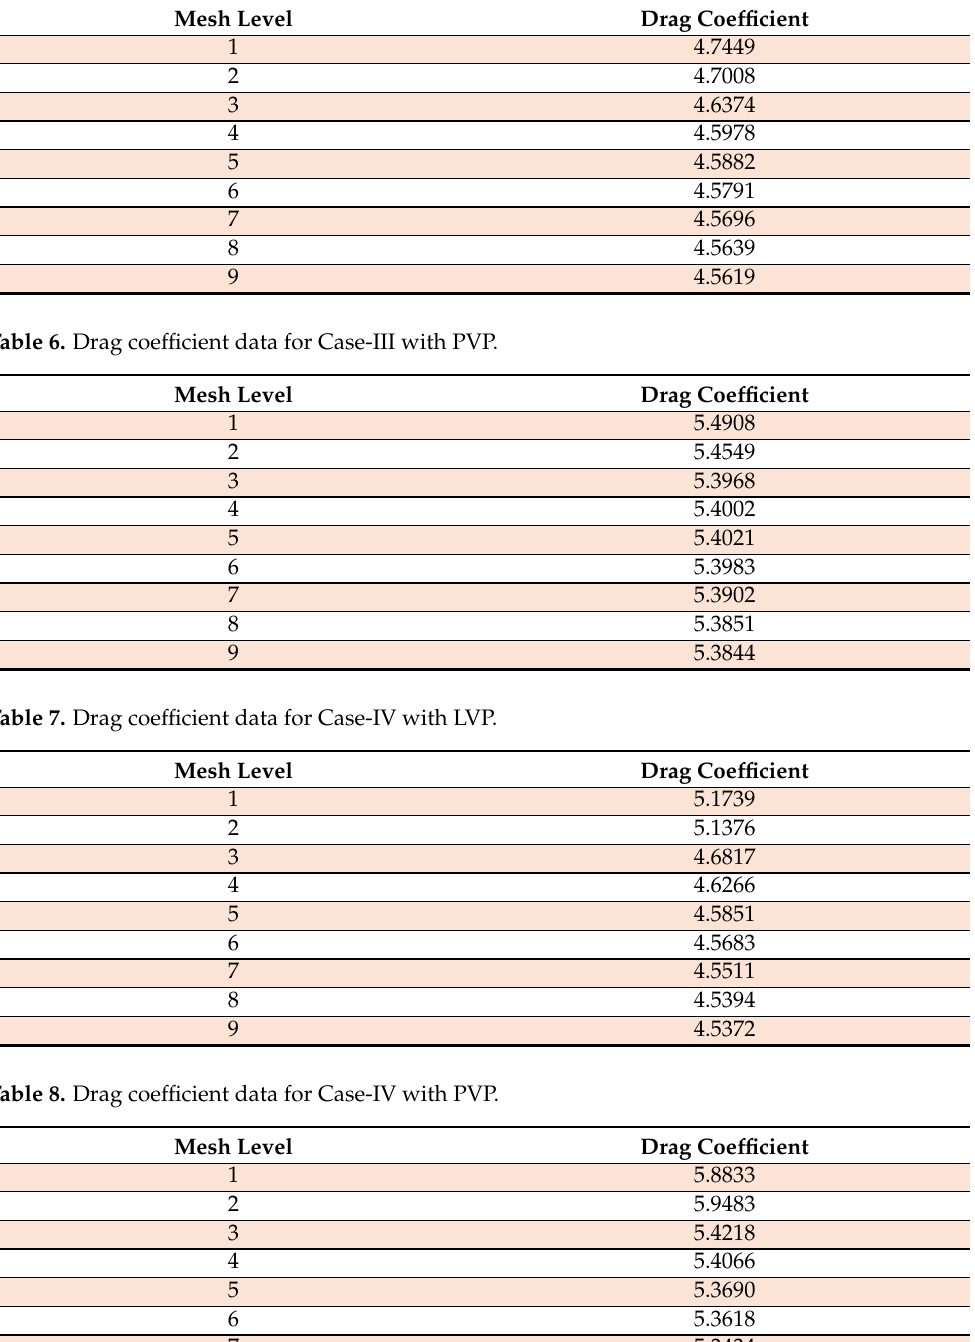
Table 5. Drag coefficient data for Case-III with LVP.